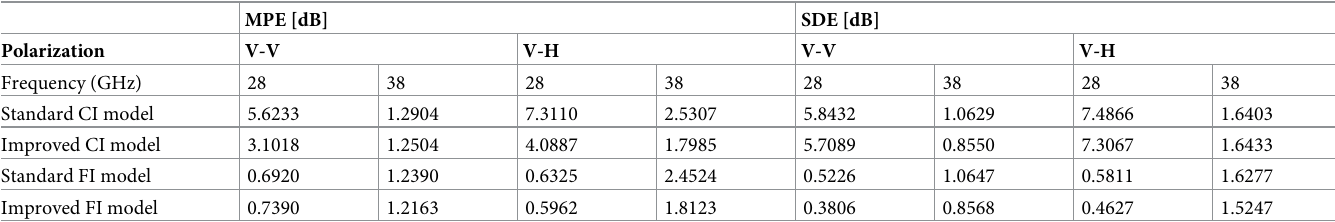
Table 7. MPE and SDE parameters for the NLOS situation.